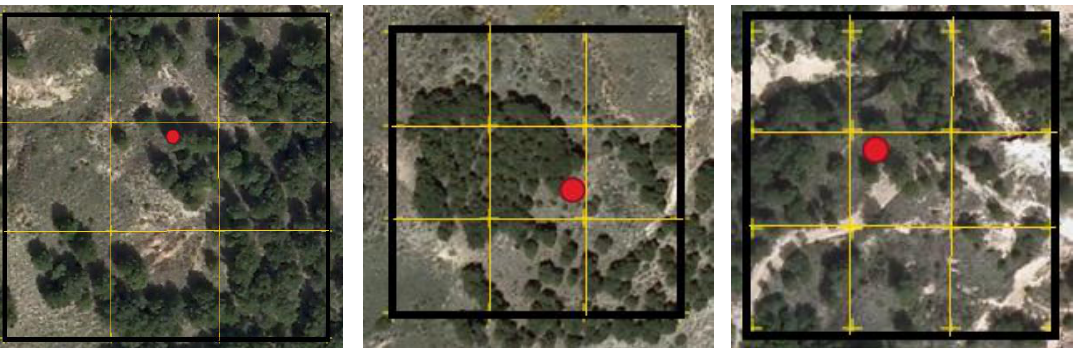
Figure 8. Examples of SNFI field plots used for V prediction purposes for PH not included in 100% of the total bootstrap iterations conducted to assess plot-to-plot variability. Yellow squares represent population units of cell size of 25 × 25 m.